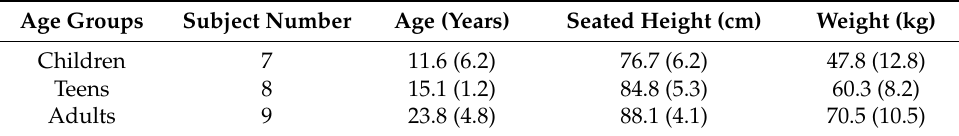
Table 1. Mean (SD) of participants’ age, and relevant anthropometrics.